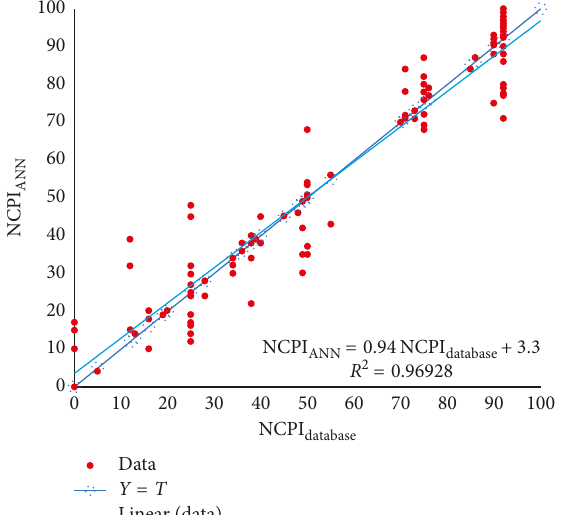
Figure 12: Correlation between the estimated safety level and the safety level from the database in the ramps.